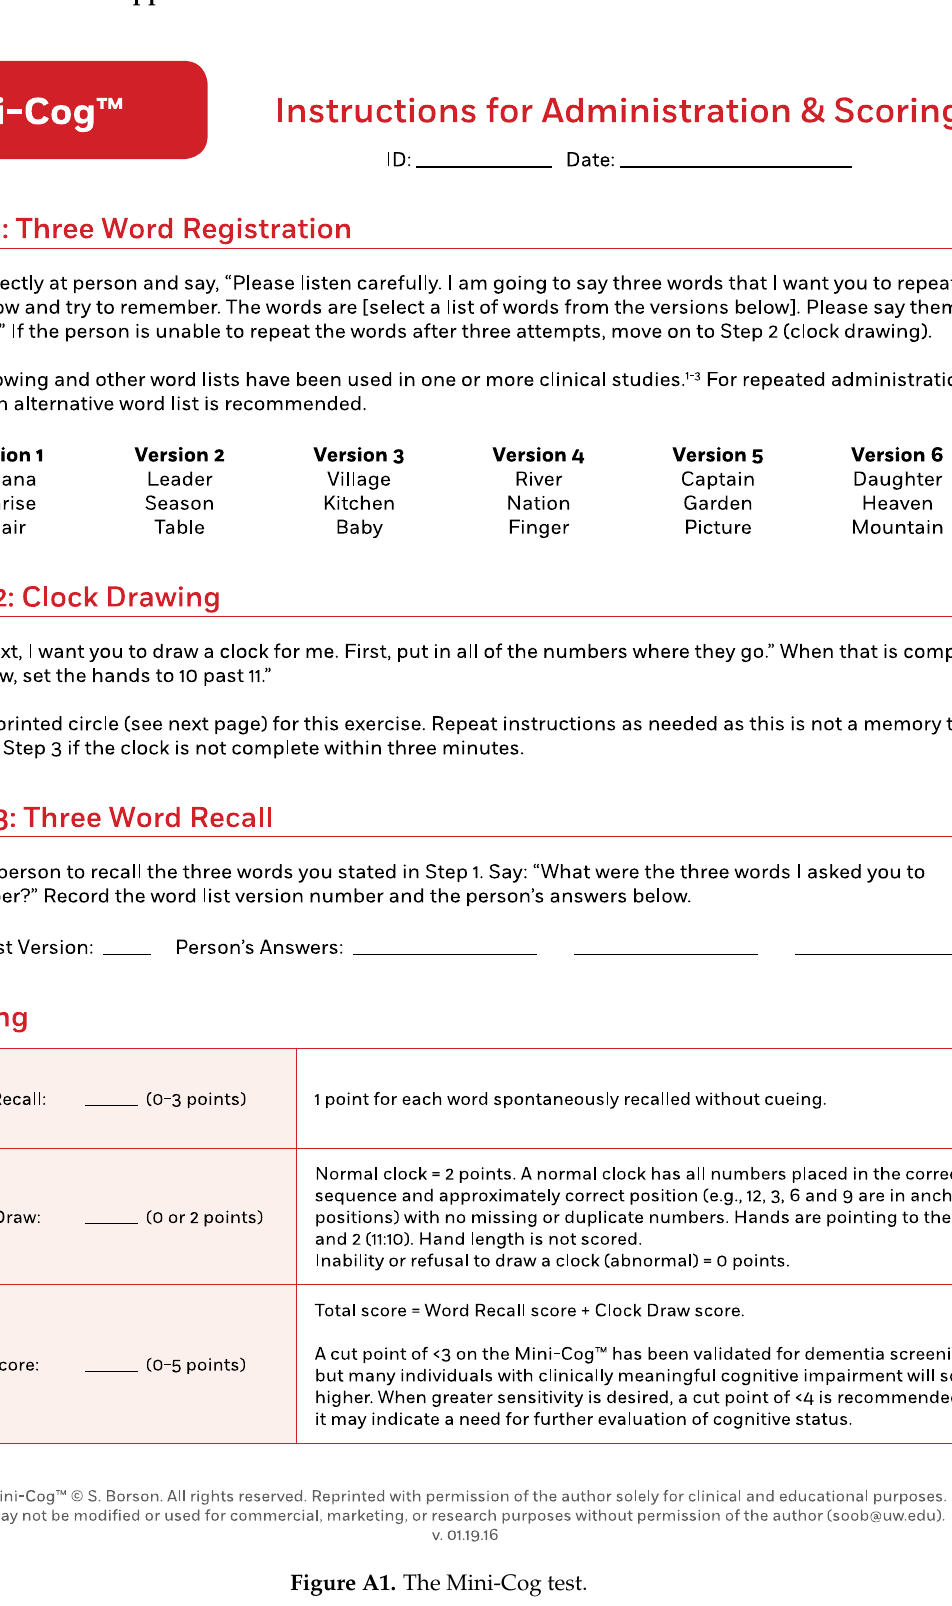
Figure A1. The Mini-Cog Figure A1. The Mini ‒ Cog test.